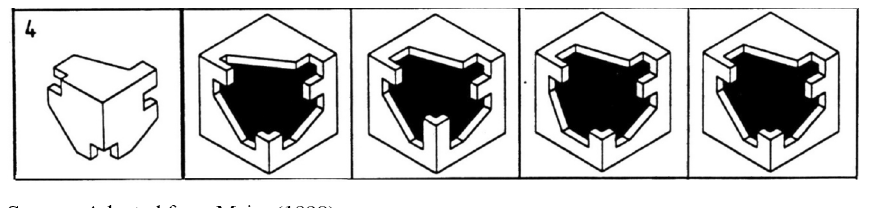
Figure 3. A common task